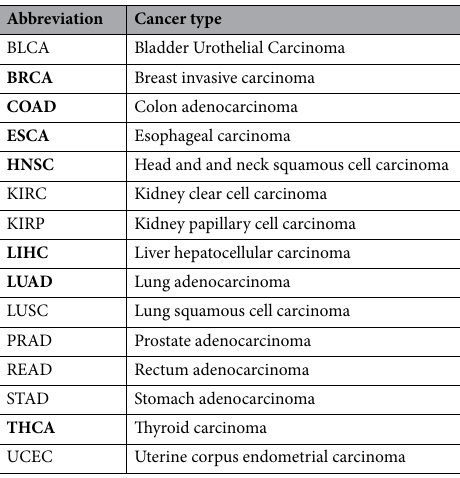
Table 1. TCGA abbreviations for the studied cancer types.